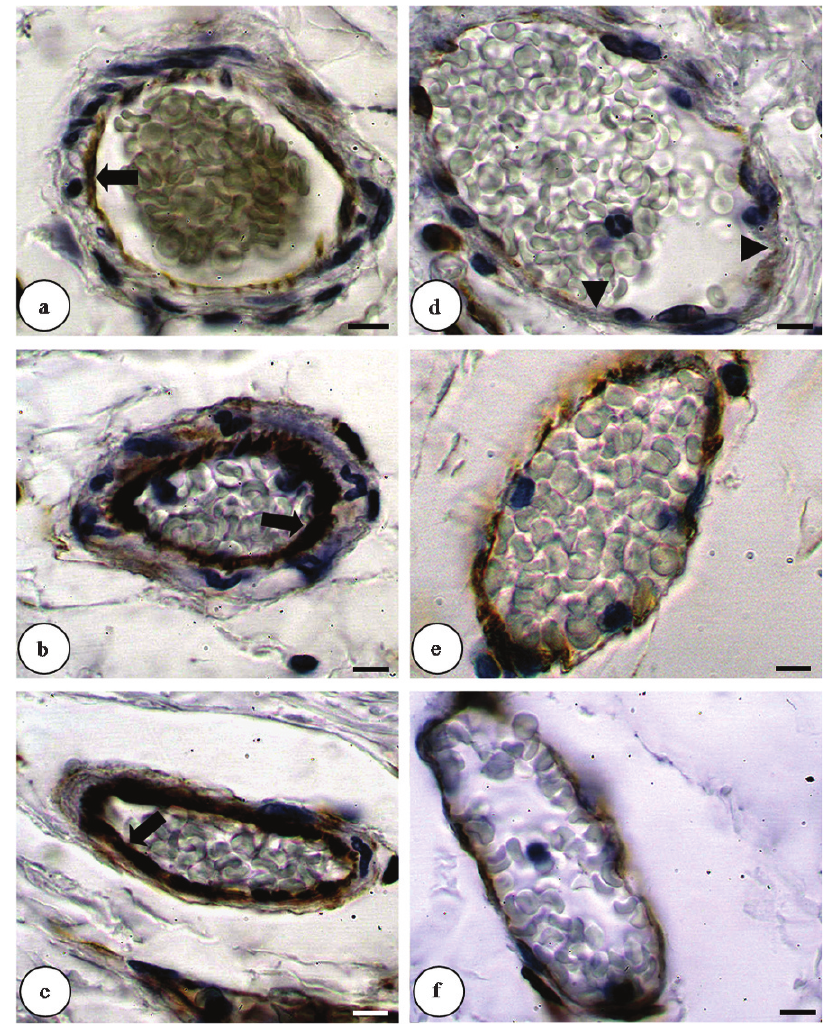
Figure 2 - Changes of vimentin expression in arterioles (A-C) and venules (D-F) by immunohistochemical staining (brown color) (light microscopy, 1,000X). a . The control group only showed a few vimentin-immunoreactive endothelial cells (arrow). b . The diabetic group (6 days) showed positively-stained endothelial (arrow) and smooth muscle cells. c . The diabetic group (15 days) showed vimentin- immunoreactive endothelial (arrow) and smooth muscle cells. d . The control group with few endothelial cells immunoreactive for vimentin (arrowhead). e . The diabetic group (6 days) with a moderate amount of vimentin expression in the intimal and media layers. f . The diabetic group (15 days) with a moderate amount of vimentin expression in the intimal and media layers. The scale bar=10